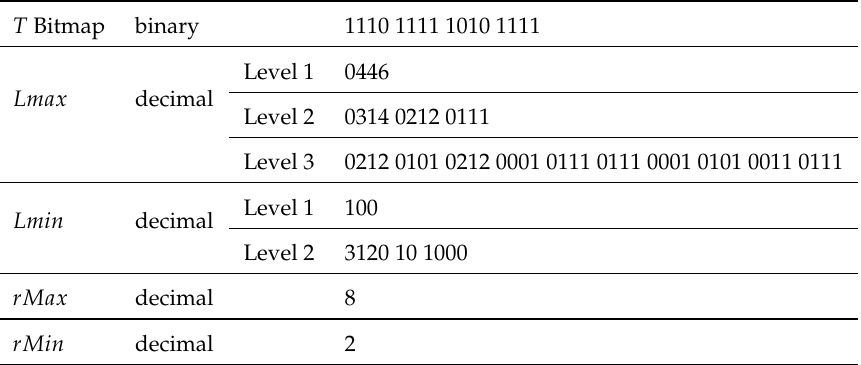
Figure 4. Based on the tree in Figure 3, the maximum value of each node is subtracted from that of its parent while the minimum value of the parent is subtracted from the node’s minimum value. These differences then replace their corresponding values in the node. The maximum and minimum values of the root remain the same. Table 1. An example of the elements of a k 2 -raster based on Figures 2–4. T